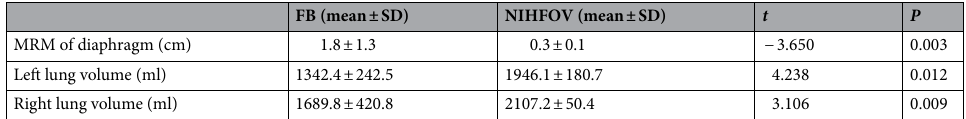
Table 1. Maximum range of motion (MRM) of the diaphragm in the cephalic-caudal axis and lung volume. FB Free breathing, NIHFOV Non-invasive high-frequency oscillatory ventilation.